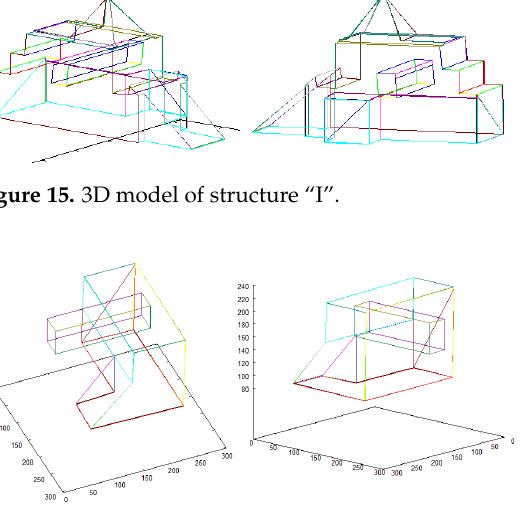
Figure 16. 3D model of structure